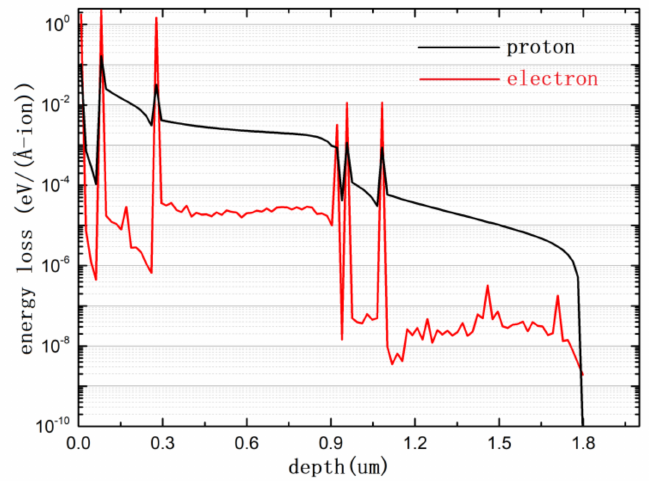
Figure 5. Energy loss varies with the depth of material